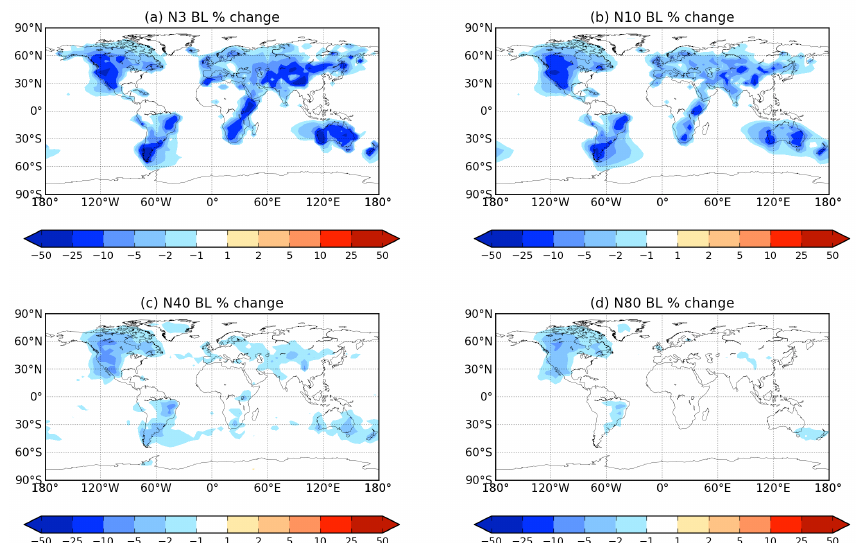
Fig. 7. Global annual-mean BL changes in (a) N3, (b) N10, (c) N40 and (d) N80 between SURF-XSOA and SURF-XSOA-H (red denotes higher concentrations in the SURF-XSOA-H simulation). There was a global BL decrease of 5.8%, 4.4%, 1.0% and 0.6% in N3, N10, N40 and N80 respectively when the semi-empirical sub-20nm growth rate parameterization was included (Häkkinen et al., 2013).